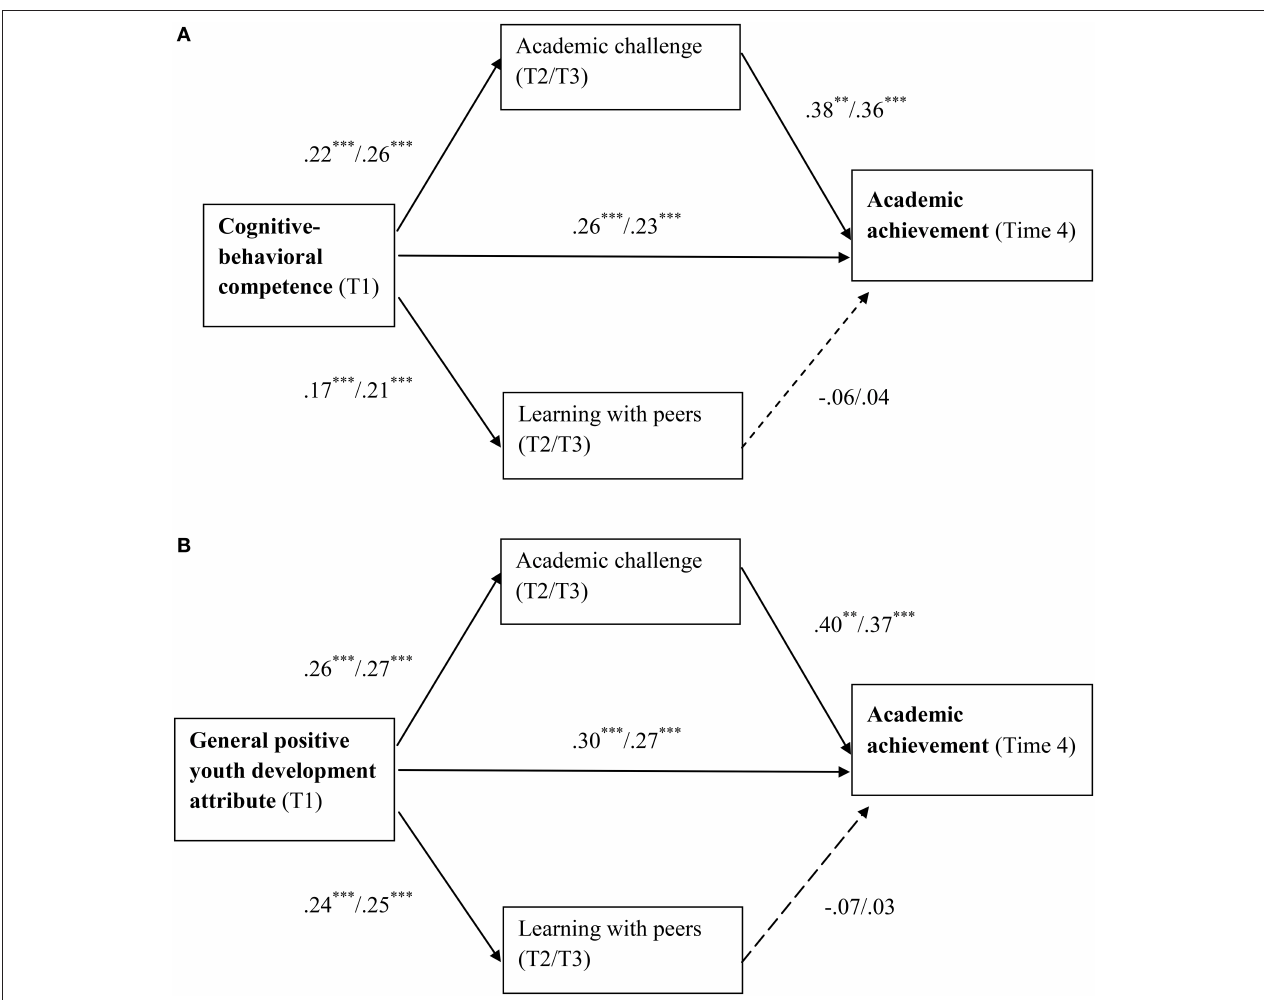
FIGURE 3 | (A) Relationships among cognitive-behavioral competence, academic achievement, and internal dimensions of university engagement. T1 = Time 1; T2 = Time 2; T3 = Time 3; T4 = Time 4. The regression coefficients shown in the figure are unstandardized values with values before and after slash representing using Time 2 and Time 3 internal dimensions of university engagement, respectively. (B) Relationships among general positive youth development attribute, academic achievement, and internal dimensions of university engagement. T1 = Time 1; T2 = Time 2; T3 = Time 3; T4 = Time 4. The regression coefficients shown in the figure are unstandardized values with values before and after slash representing using Time 2 and Time 3 internal dimensions of university engagement, respectively. ** p < 0.01; *** p <